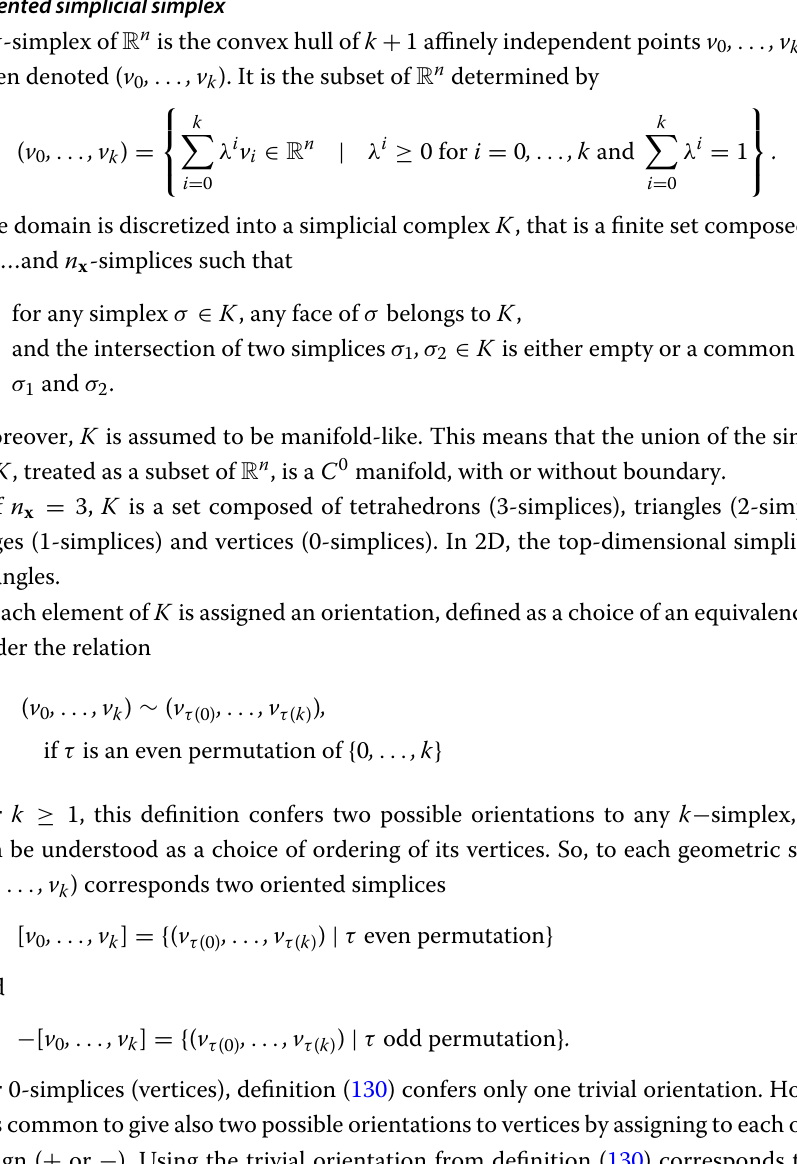
Oriented simplicial